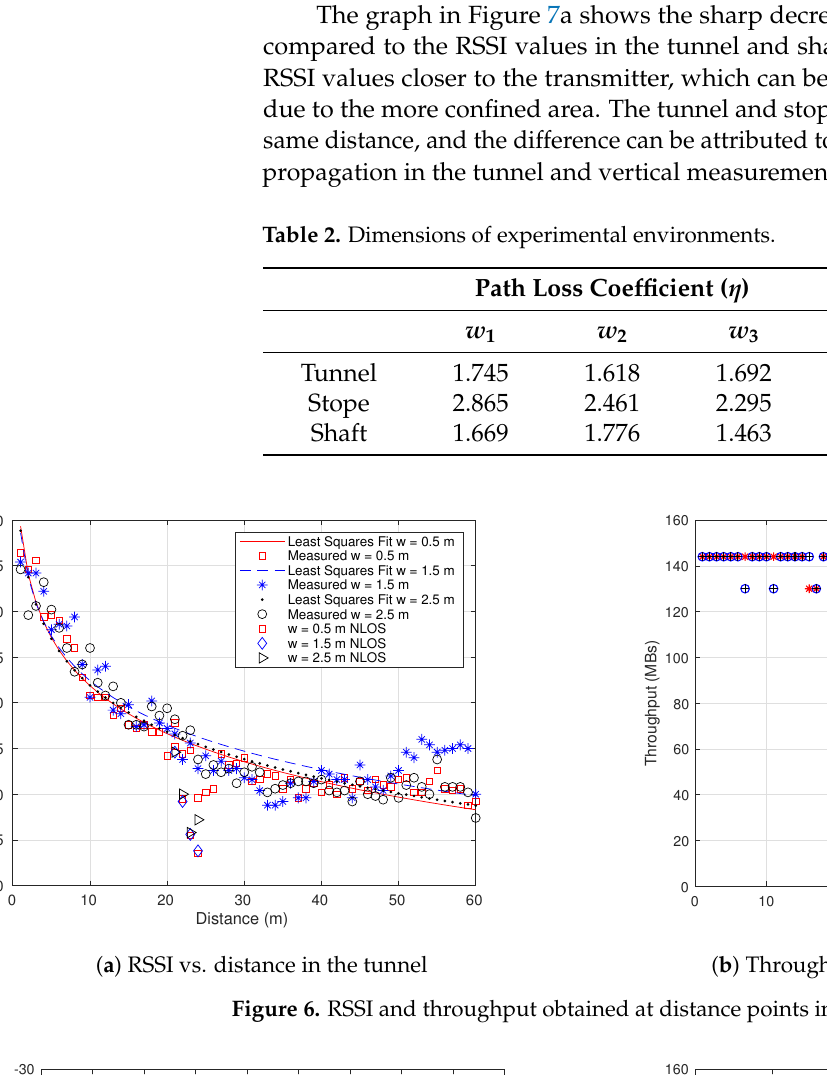
Least Squares Fit w = 0.35m Measured w = 0.35m Least Squares Fit w = 1.35m Measured w = 1.35m